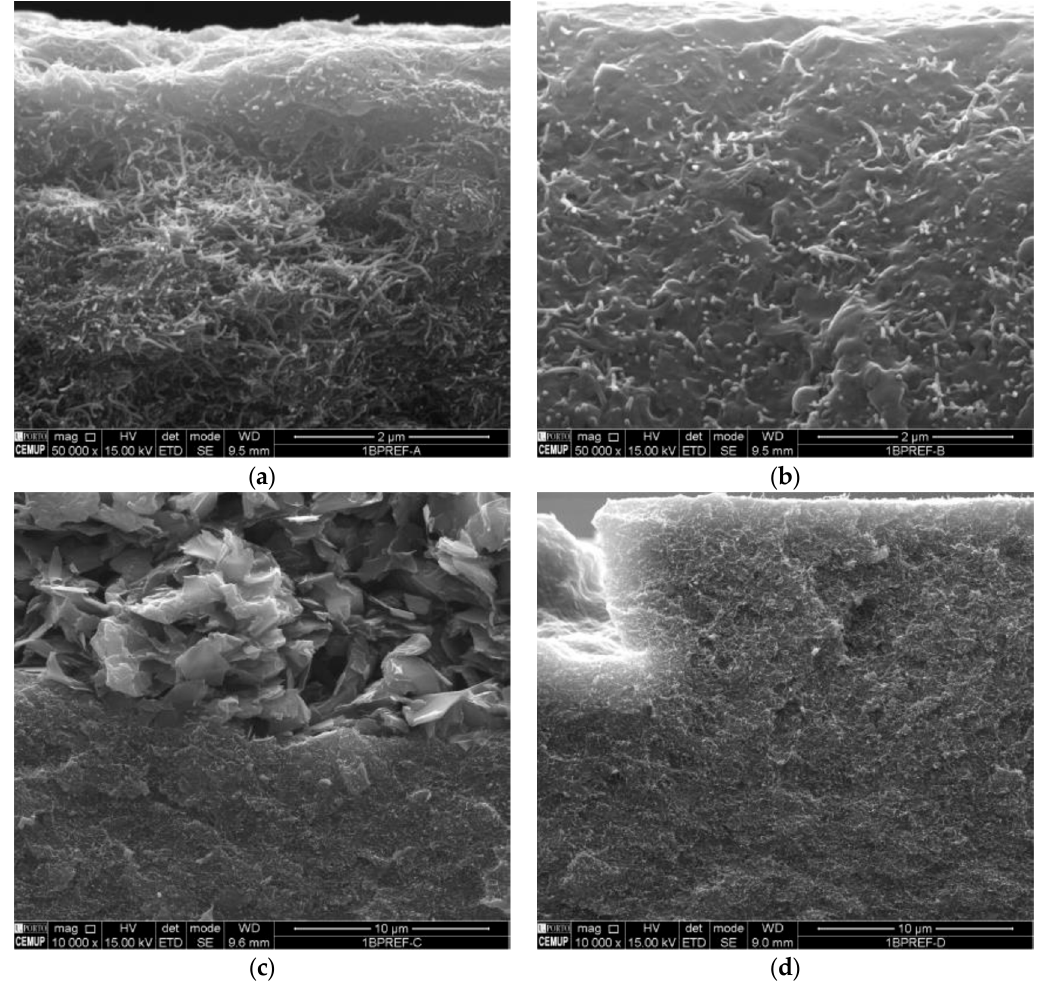
Figure 9. SEM images (through thickness) of the CNT-BP samples: ( a ) BP-1, ( b ) BP-2, ( c ) BP-3, ( d ) BP-4. Table 13. Thermal diffusivity and conductivity values of graphite and CNT-based samples.